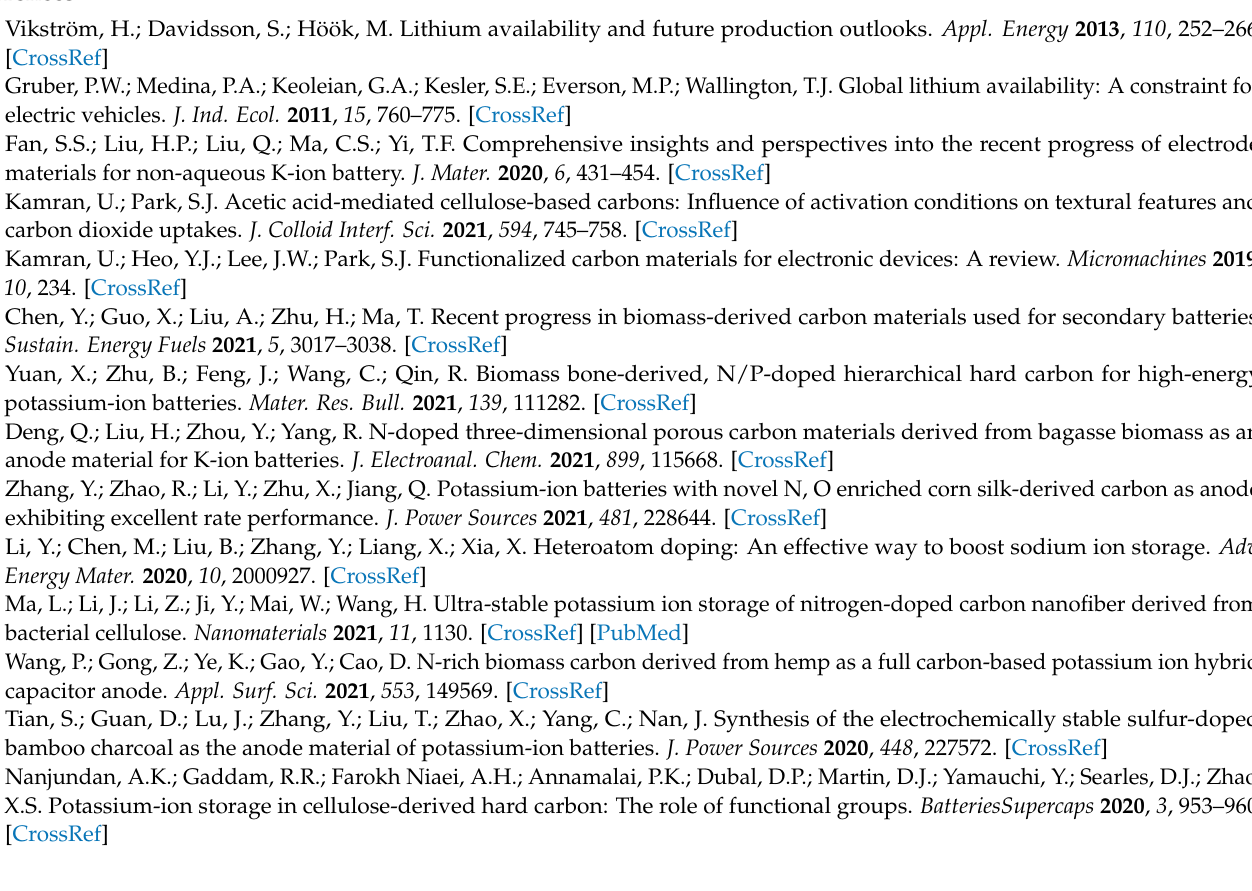
OPDC; Figure S2: Illustration of the calculation for domain thickness; Figure S3: FTIR of OPDC; Figure S4: Contribution ratio of the surface adsorption behavior at the scan rate of 0.7 mV/s; Figure S5: (a) XRD patterns of the OPDC electrode during discharging and charging, (b) the corresponding gal- vanostatic charge/discharge profile, and (c) Raman spectra of the OPDC electrode during discharging and charging; Figure S6: Schematic diagram of the potassium-ion storage mechanism in the OPDC electrode; Table S1: R SEI and R ct simulated from equivalent circuit analysis at different cycles; Table S2: Comparison of the electrochemical performance between OPDC and partial biomass-derived carbon. References [7–9,11,13,16,46–56] are cited in supplementary